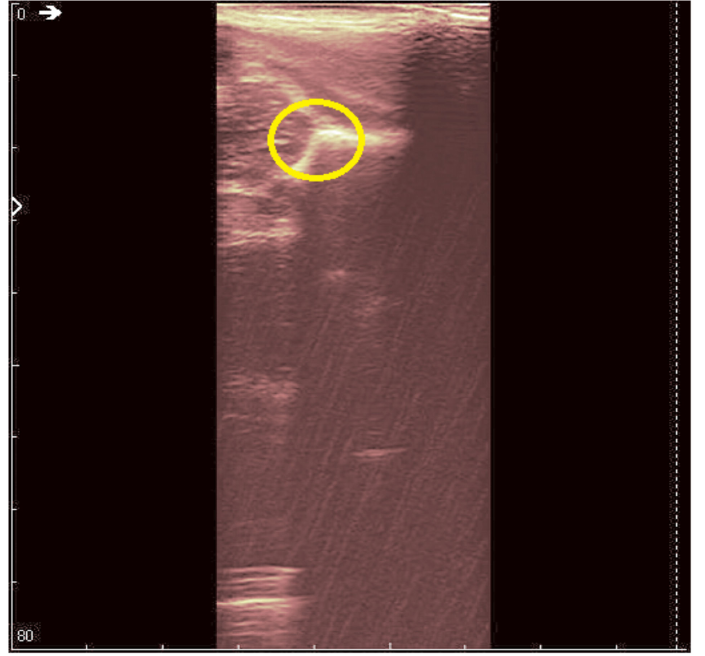
Figure 5. Same region of interest as in Figure 4 was encircled in yellow. The interior speckle grains have disappeared.